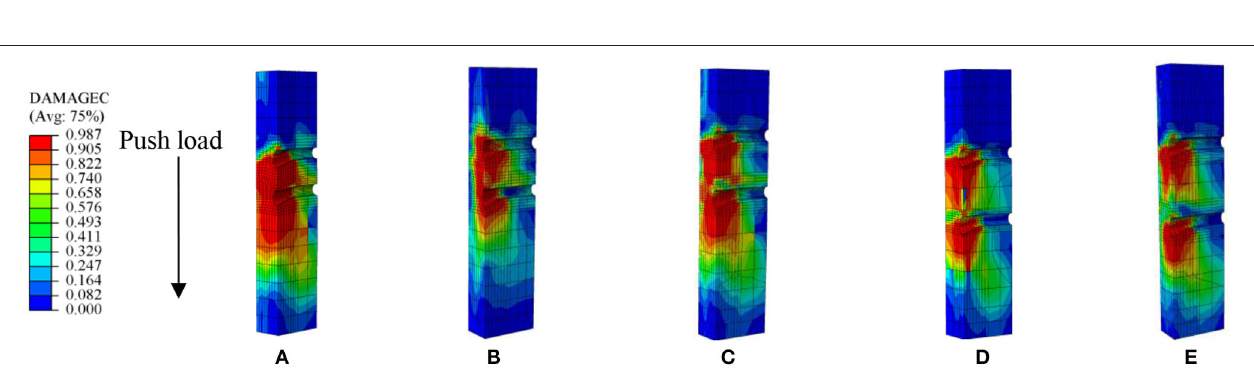
FIGURE 8 | Analyzed compressive damage on the concrete slab: (A) l = 4 d ; (B) l = 5 d ; (C) l = 6 d ; (D) l = 7 d ; and (E) l = 8 d .